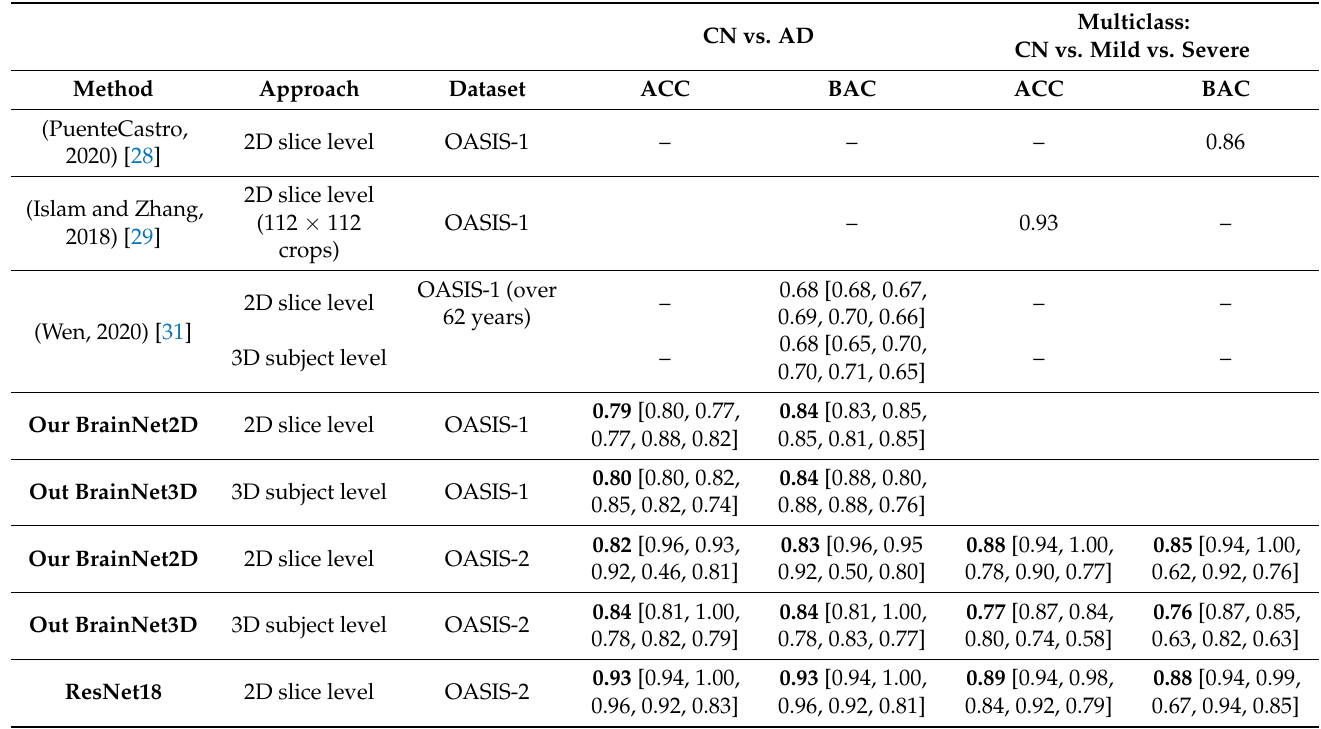
Table 5. Comparison of the obtained results with the state-of-the-art methods that use the OASIS dataset for a two- class classification problem: Cognitive normal and Alzheimer’s disease. Comparison of results for a multiclass problem: Cognitive normal, Alzheimer’s disease in very mild state and Alzheimer’s disease in severe